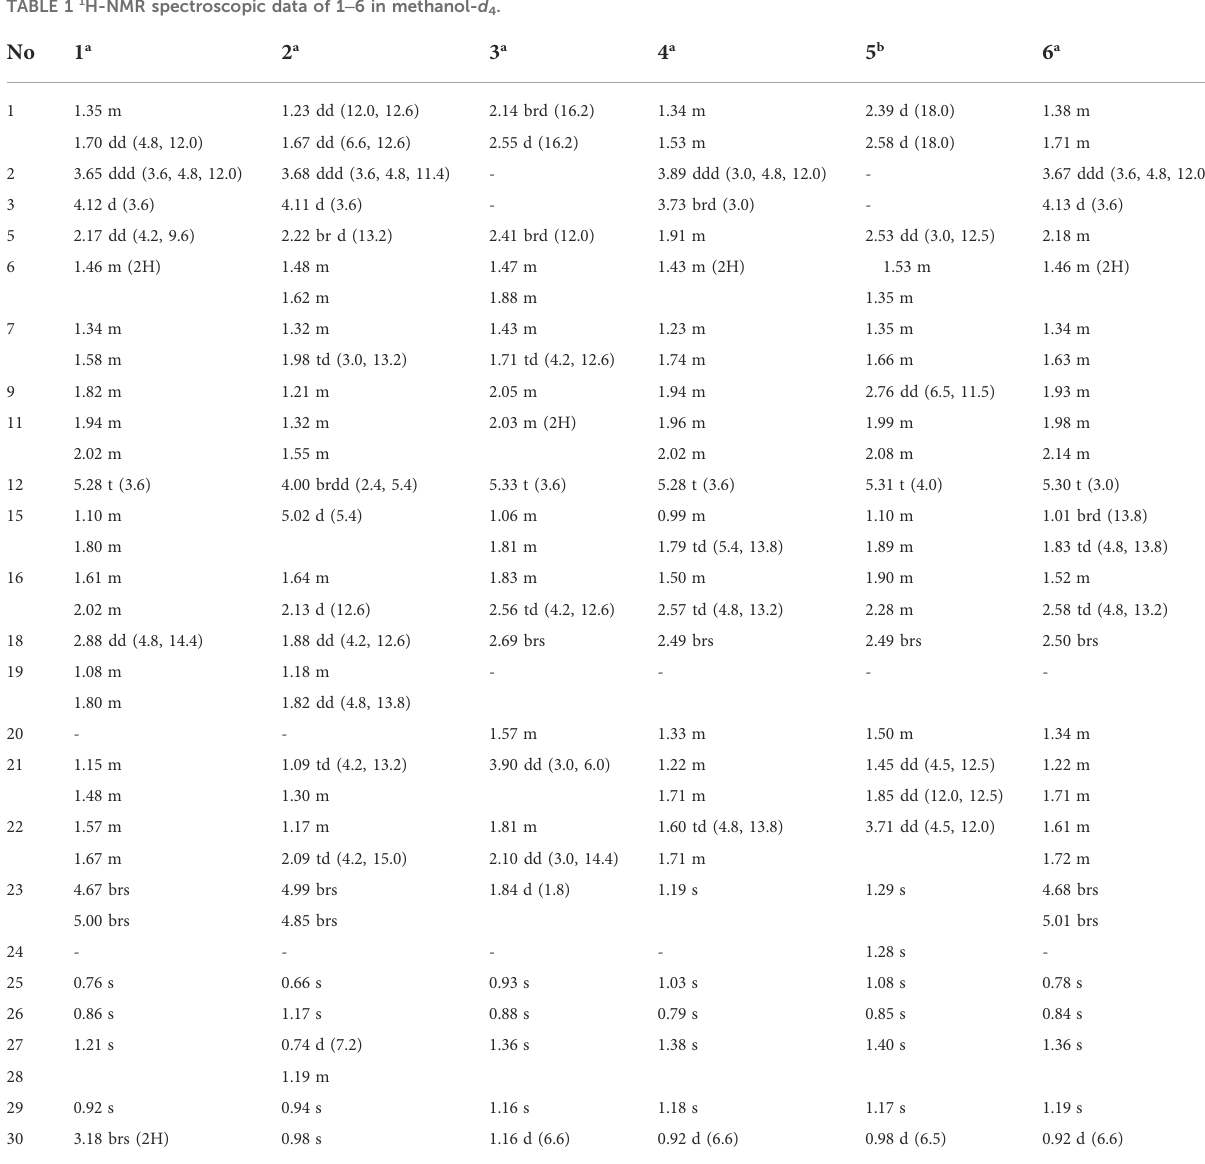
TABLE 1 1 H-NMR spectroscopic data of 1 ‒ 6 in methanol- d 4